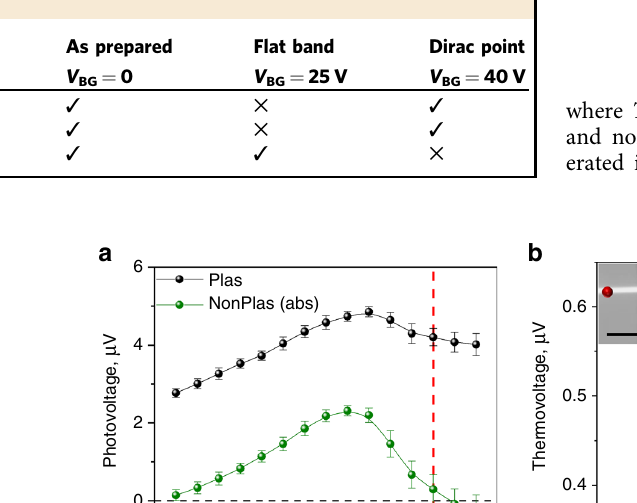
Table 1 Summary of contributing effects under different gate bias: ✓ — the effect is active and ✕ — the effect